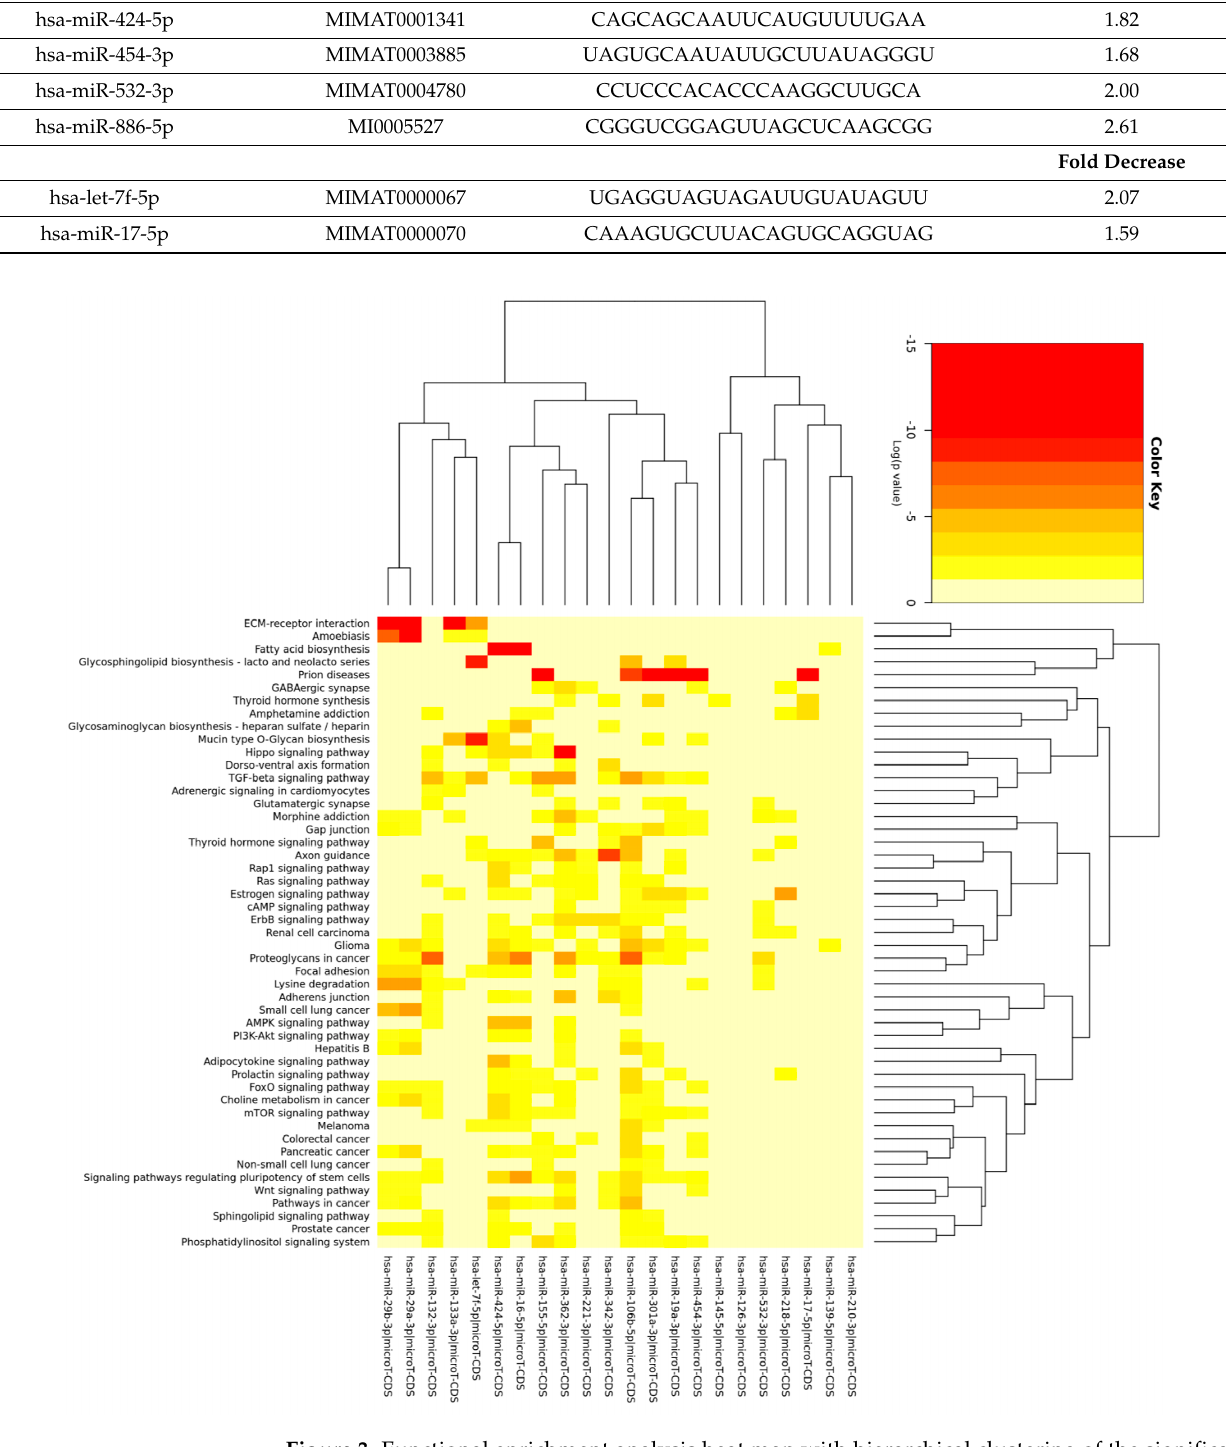
Figure 3. Functional enrichment analysis heat map with hierarchical clustering of the significantly enriched KEGG pathways. The coloured scale bar represents LOG ( p -value) from 0 to –15 where red indicates more significance and yellow indicates less significance. The background colour of the heat map or 0 of the scale bars represent no significance. Each row represents a KEGG pathway, and each column represents a miRNA. The miRNA clustering tree or dendrogram is shown at the top and the KEGG pathway clustering tree or dendrogram is shown on the right.